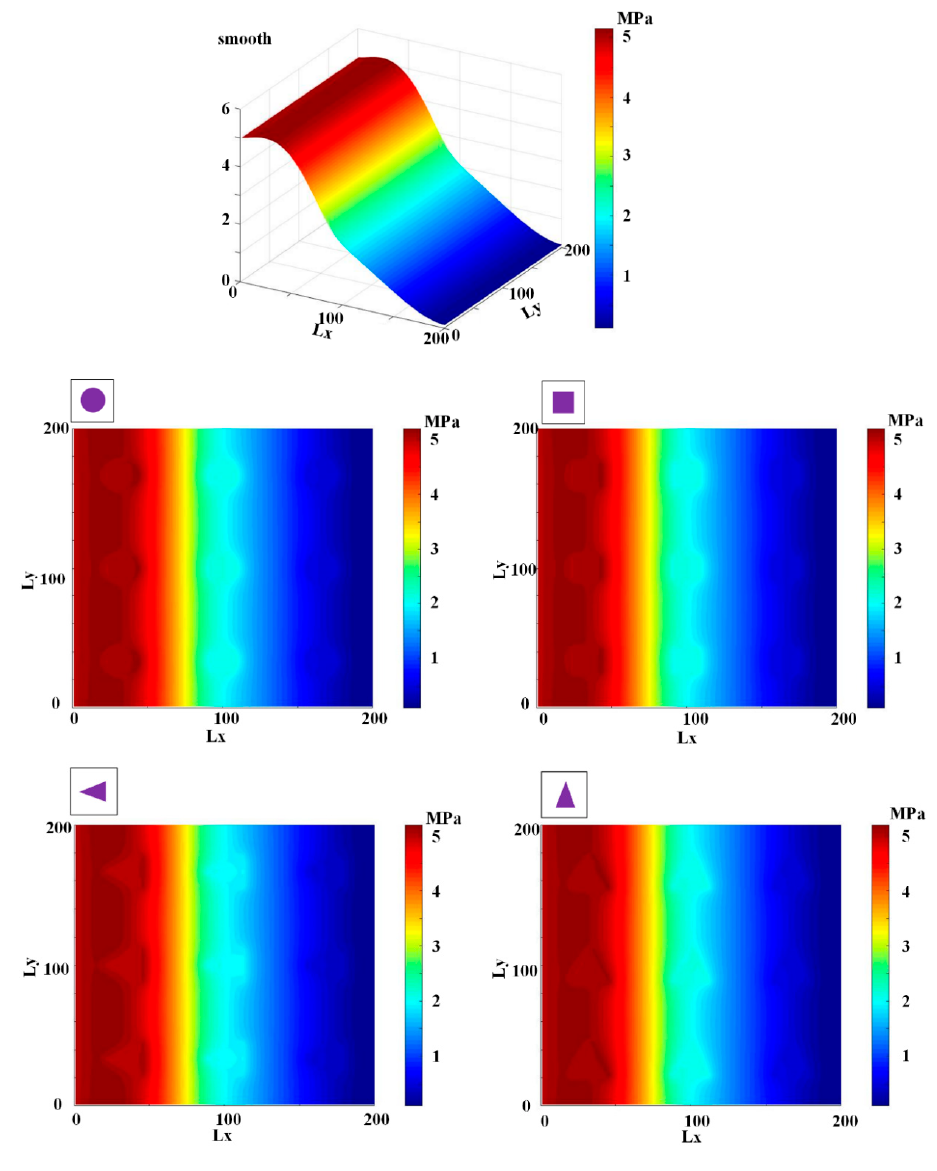
Figure 9. Fluid pressure during outstroke.